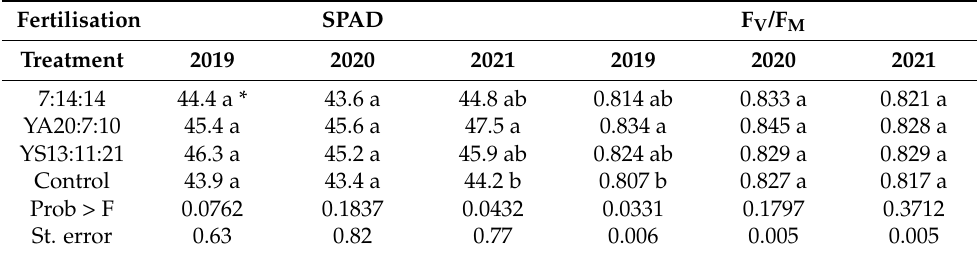
Table 2. SPAD-readings and F V /F M (ratio of variable fluorescence/maximum fluorescence) as a function of fertilisation treatments.